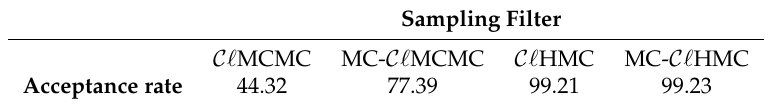
Figure 2. The one-dimensional example. A GMM prior, a Gaussian likelihood, and the resulting posterior, along with histograms of 1000 sample points generated by the (cid:96) HMC ( c ), and the MC- (cid:96) HMC ( d ) sampling algorithms. The symplectic integrator used for ( b ), C C HMC filters is Verlet with pseudo-time stepping parameters T = mh with m = 20, and h = 0.045. The number of burn-in steps is zero, and the number of mixing steps is 20. Table 1. Acceptance rates of the cluster sampling filters, for the one-dimensional